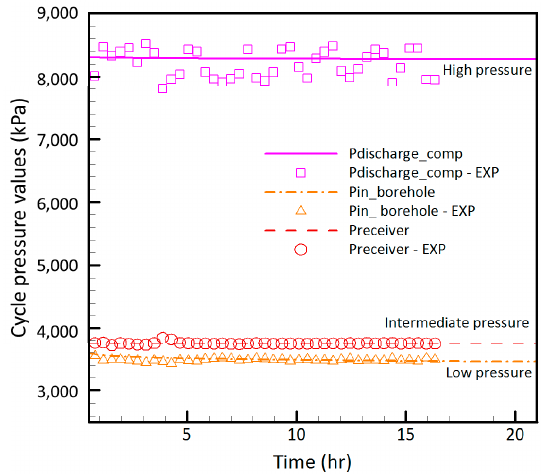
Figure 2. Cycle pressure levels.